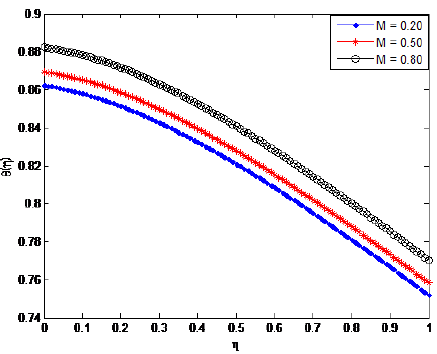
Figure 2. Influence of Hartman number on